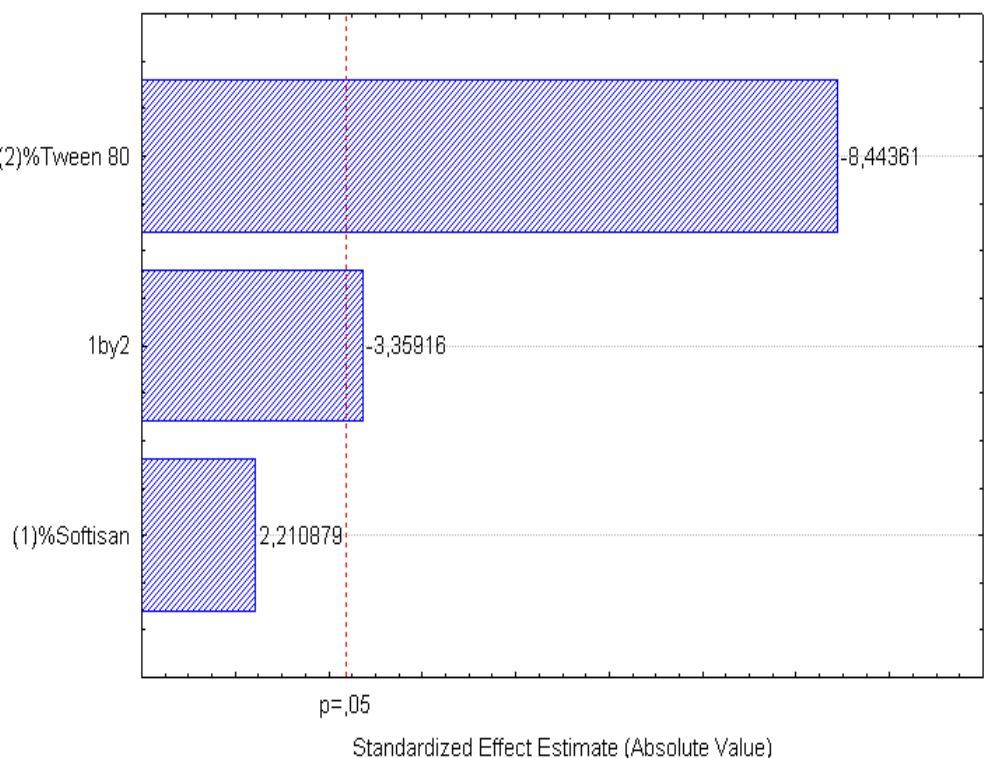
Figure 5. Pareto chart of the analyzed effects for PI.